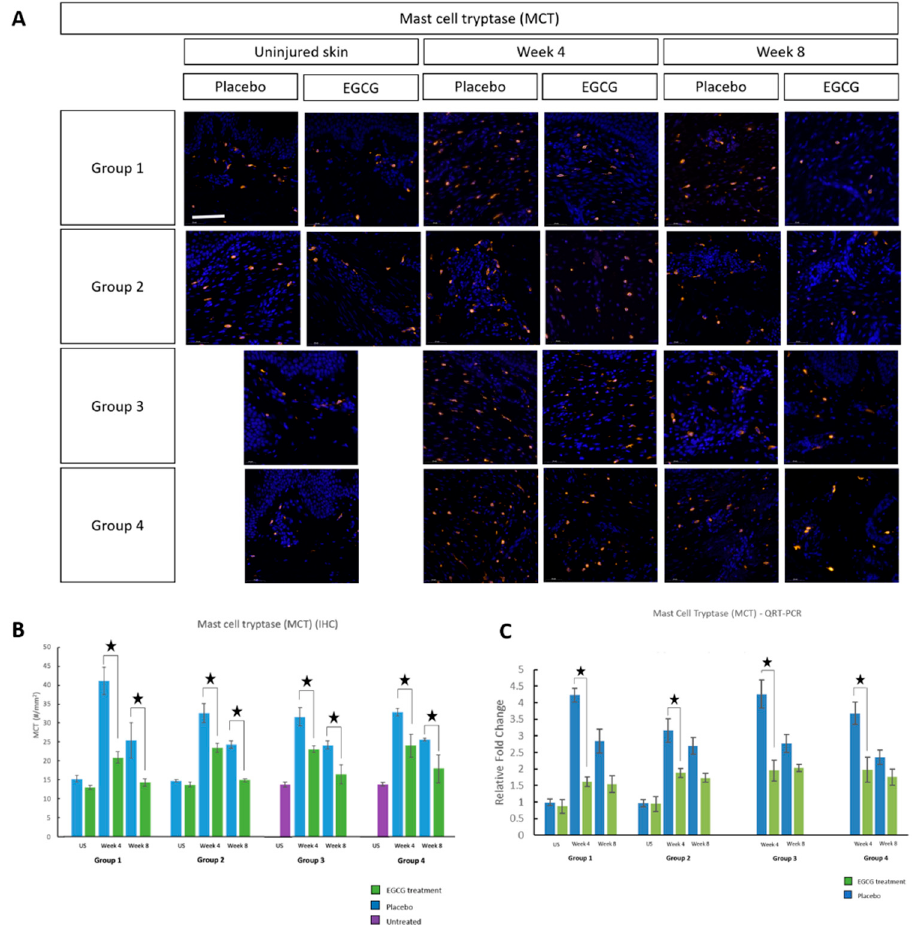
Figure 4. Mast cell tryptase (MCT) analysis of topical epigallocatechin-3-gallate (EGCG) versus placebo. ( A ) MCT immunohistochemical marker images demonstrate a reduction with EGCG in all groups compared to placebo at weeks 4 and 8. ( B ) MCT measurements (#/mm 2 ) showed that EGCG-treated scars were significantly lower at weeks 4 and 8 compared to placebo ( p < 0.01) for all groups. Between group analysis demonstrated a significant difference at week 4 (Anova p = 0.001) and this was identified as Priming Group 1 (7 days priming) with the greatest differences compared to Group 2 ( p = 0.002), Group 3 ( p = 0.003) and Group 4 ( p = 0.005). ( C ) Quantitative real-time reverse transcriptase–PCR (QRT-PCR) analysis confirmed down-regulation of MCT ( p < 0.05) in EGCG samples compared to placebo at week 4 in all groups. Significance: (cid:70) p ≤ 0.01. Error bars: mean ± SD. Scale bars = 50 µ m. (DAPI = blue, MCT =